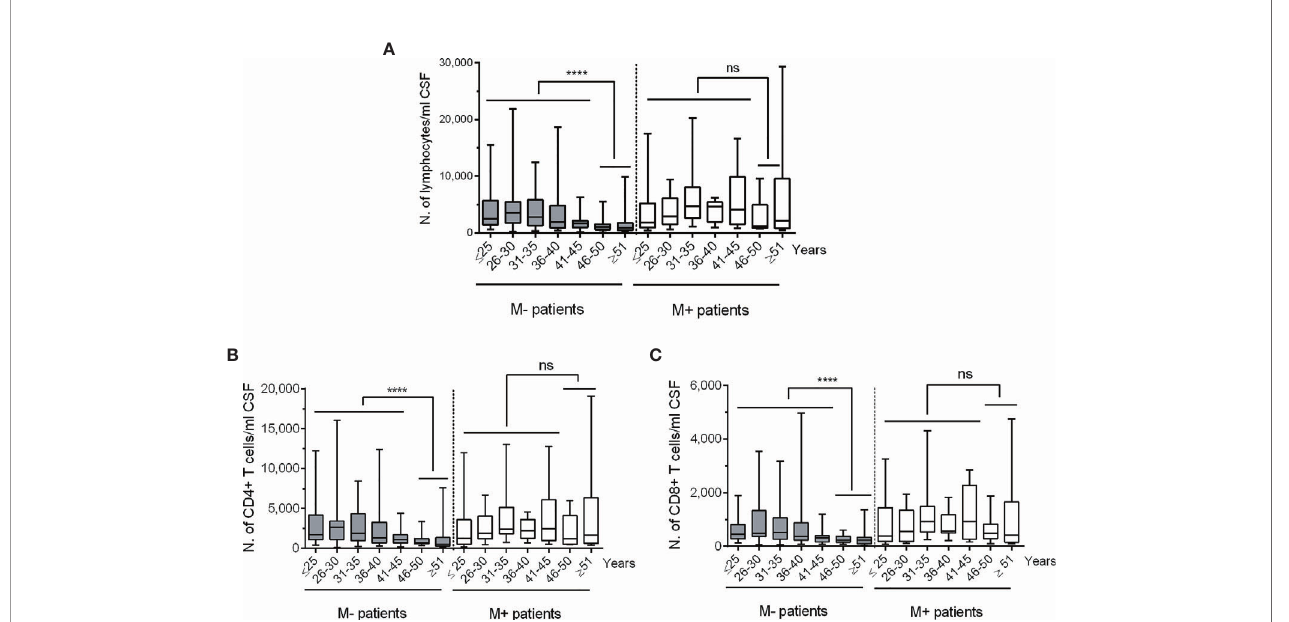
FIGURE 2 | Changes in CSF lymphocyte counts in MS patients classi fi ed according to age and to the absence or presence of lipid-speci fi c oligoclonal IgM bands (LS-OCMB). Absolute cell numbers (N.) of CSF total lymphocytes (A) , CD4+ (B) and CD8+ (C) T lymphocytes were studied in multiple sclerosis patients lacking (M-, grey bars, n=191) and showing (M+, white bars, n=72) LS-OCMB, classi fi ed according to their age: ≤ 25, 26-30, 31-35, 36-40, 41-45, 46-50 and ≥ 51 years. ns, not signi fi cant. ****p < 0.0001.